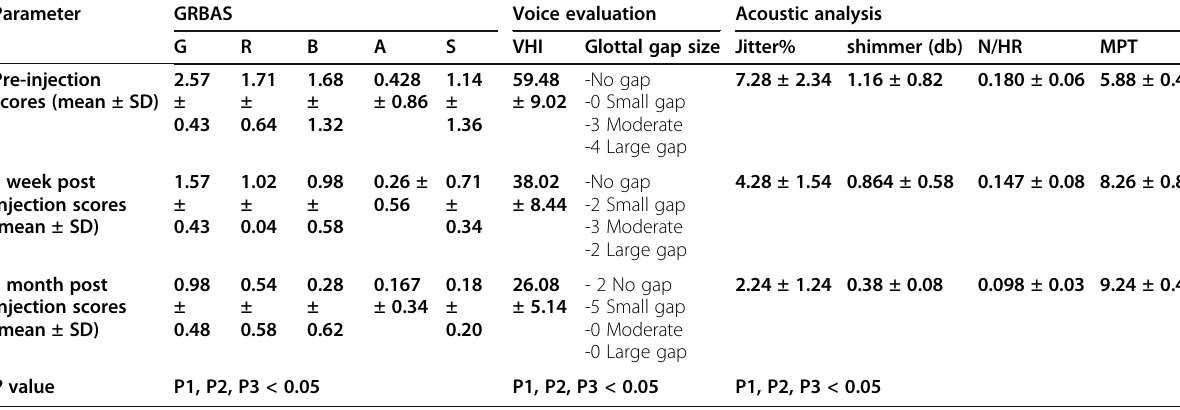
Table 3 Comparison between pre-injection and post-injection results of voice analysis after IL by general anesthesia ( n = 7) Parameter GRBAS Voice evaluation Pre-injection 2.57 scores (mean ± SD) ±